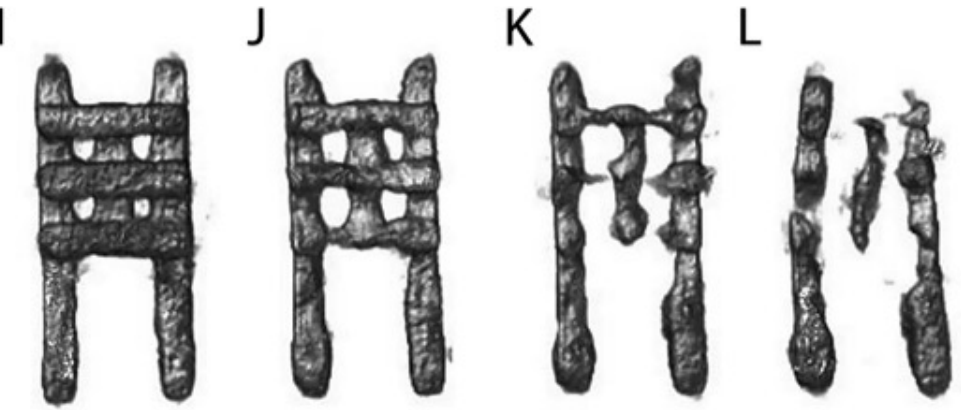
Figure 9. Top view of representative µCT scans of Mg-PCL implants without previtalisation ( A – D ), or previtalised with either murine osteoblasts ( E – H ) or mADMSCs ( I – L ) at days 0 ( A , E , I ), 28 ( B , F , J ), 56 ( C , G , K ) and 84 ( D , H , L ).